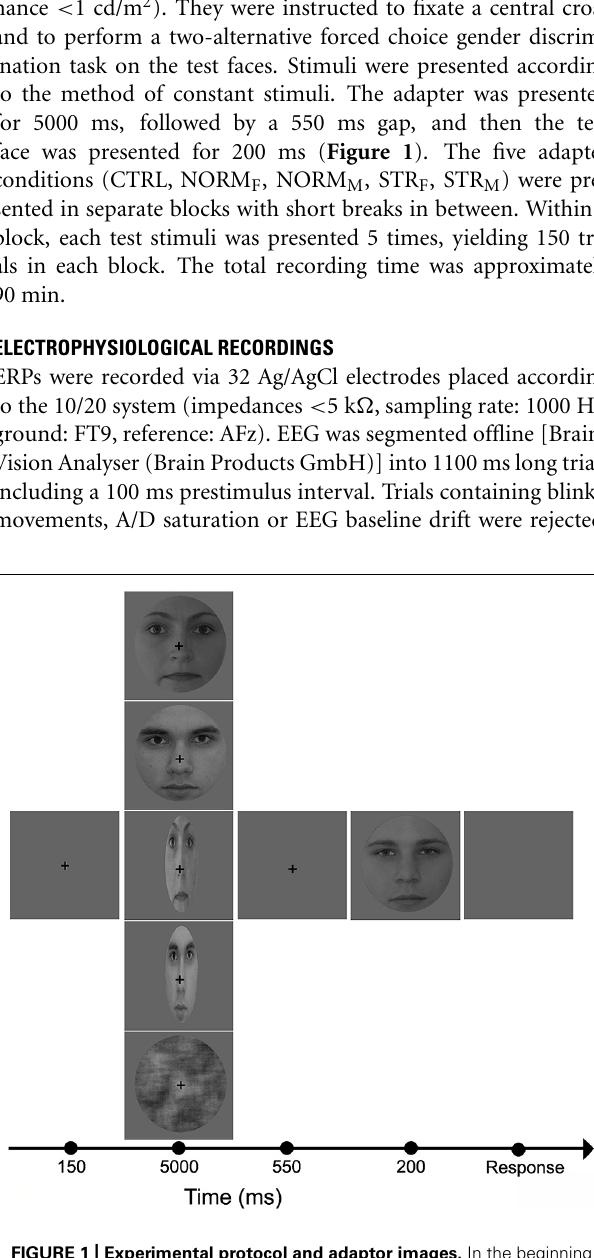
FIGURE 1 | Experimental protocol and adaptor images. In the beginning of each trial, a fixation cross was presented in the center of the screen for 150 ms, followed by one of the five adaptor images (from top to bottom: NORM F , NORM M , STR F , STR M , and CTRL) which was visible for 5000 ms.This was followed by the presentation of a blank screen for 550 ms, and then the test face was displayed for 200